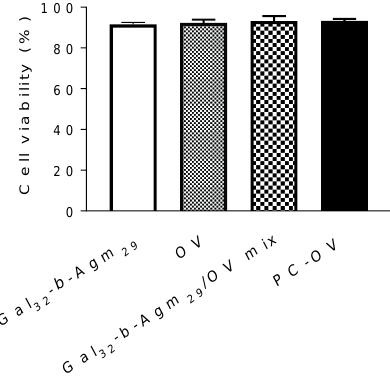
Figure 3. Cell viability on human juvenile fibroblasts. Cell viability was performed by MTS assay on juvenile fibroblasts (incubation time 96 h). The absorbance was measured with a 96-wells plate spectrophotometer Varioskan Flash Multimode Reader set at the wavelength of 490 nm. The number of apoptotic and necrotic cells was assessed to investigate in depth the effect of the virus coating on the pharmacological performance of OV. Figure 4A,C show that HepG2 incubation with PC-OV resulted in an increased num- ber of apoptotic and necrotic cells (>40%), as compared to the other samples. On the con- trary, Figure 4B,D show that the number of apoptotic and necrotic A549 cells was gener- ally low (below 20%) in all treatments.